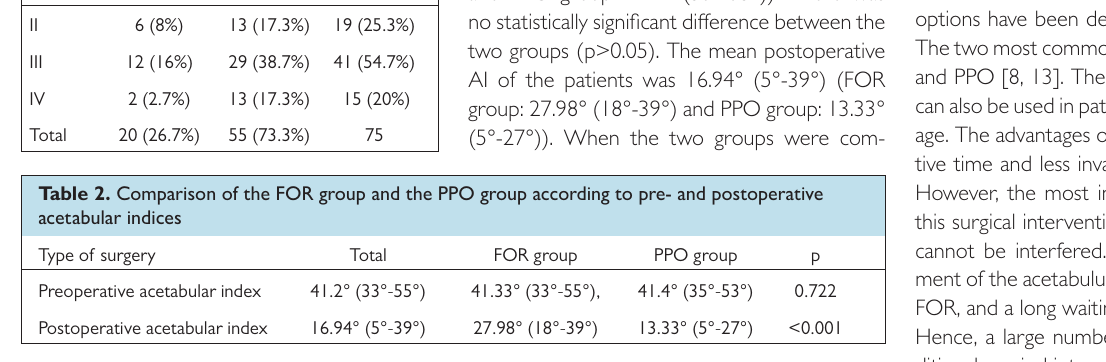
Table 3. Comparison of the FOR group and the PPO group according to the Kalamchi–McEwen criteria [12] Type Criteria